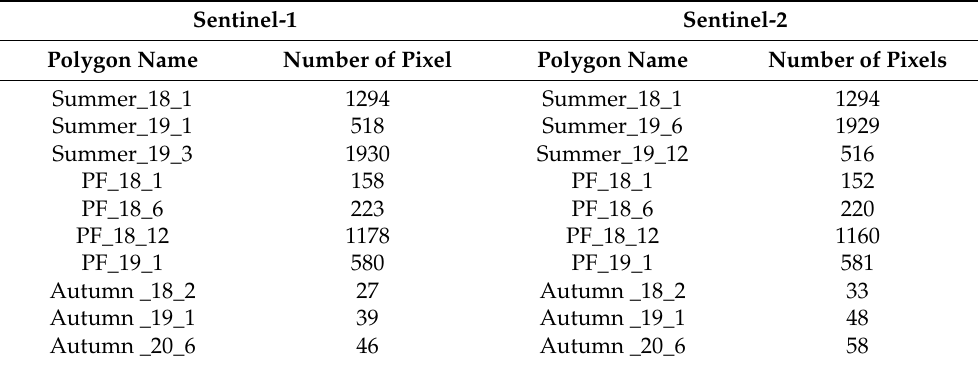
Table 1. Number of pixels for each polygon for the Sentinel-1 and Sentinel-2 images. Sentinel-1